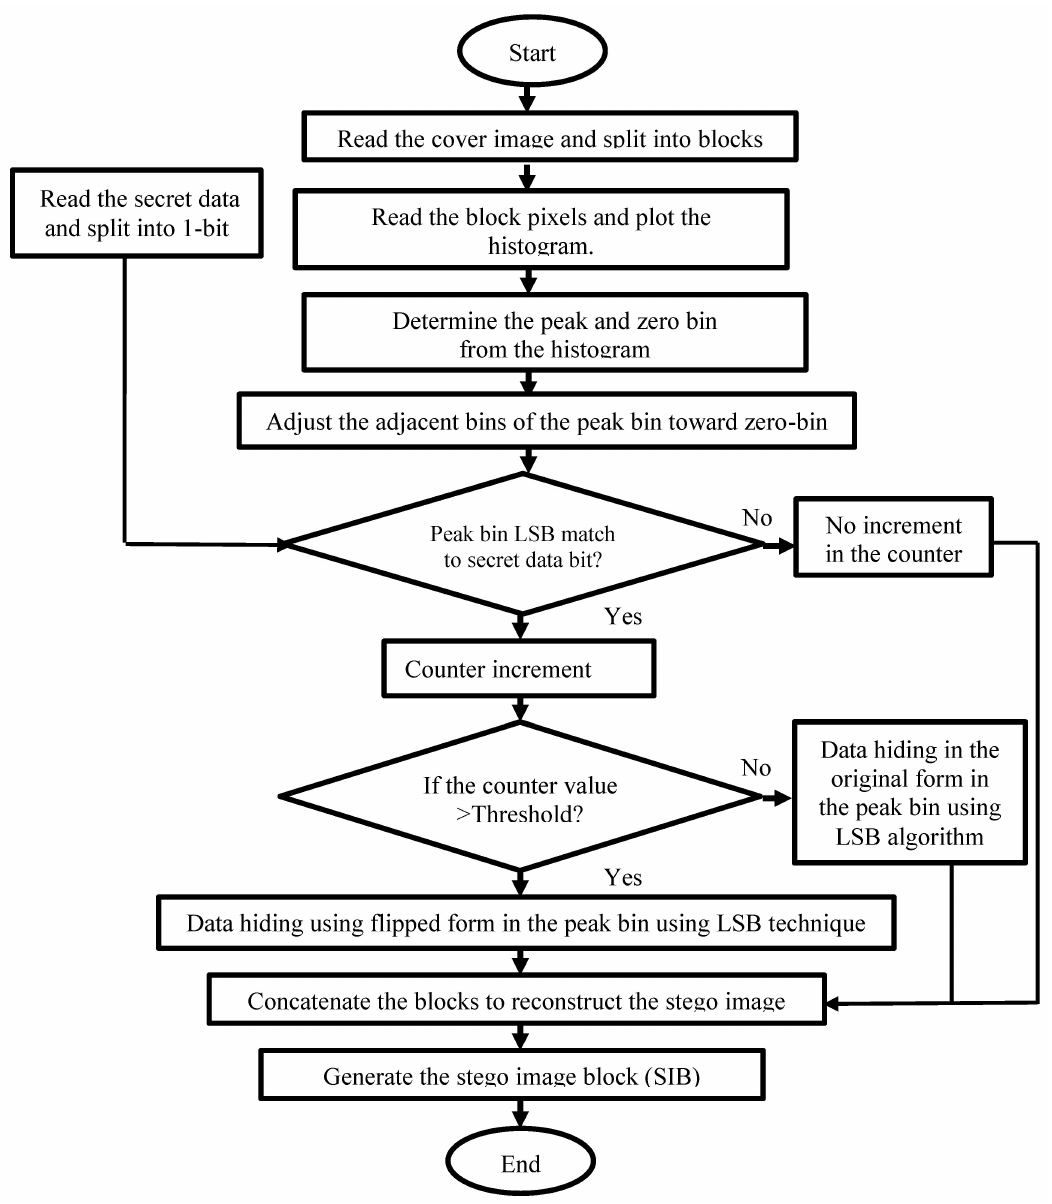
Figure 2. Flowchart for the proposed data embedding